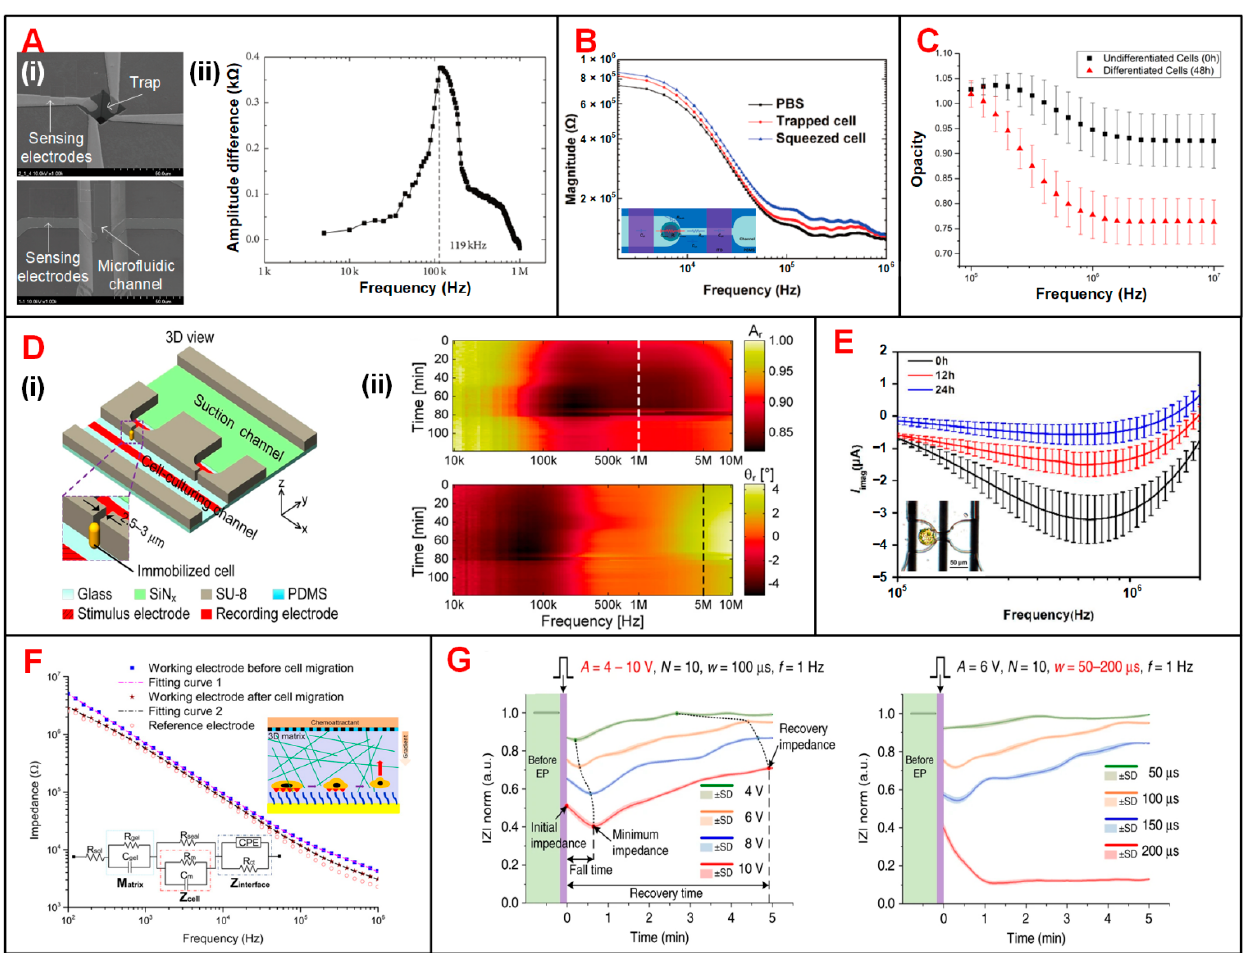
Figure 9. Cell-based assay using EIS sensing devices. ( A ) ( i ) SEM images of the two devices used to detect cancerous urothelial cells. Left one is an EIS sensing device with a negative pressure trap used to investigate the optimal frequency. Right one is an IFC device to perform high-throughput electrical impedance measurement of normal and cancerous urothelial cells. ( ii ) Measurement of the amplitude difference between normal and cancerous urothelial cells in the frequency range of 5 kHz to 1 MHz. Reproduced from [150] with the permission from Hindawi. ( B ) Schematics of a EIS sensing device to measure the amplitude and phase signal of MCF-7 cells under three typical conditions: PBS solution without cells, cell trapped and cell squeezed. Reproduced from [82] with the permission from Springer. ( C ) Using a EIS sensing device with microfluidic traps to distinguish the undifferentiated and differentiated cells by measuring the impedance over the frequency range from 100 kHz to 10 MHz. Reproduced from [95] with the permission from Elsevier. ( D ) ( i ) Schematics of an EIS-integrated single-cell culturing device for immobilization and impedance recording of Schizosaccharomyces pombe ( S. pombe ) cells. ( ii ) Recorded EIS amplitude and phase signals over the frequency range from 10 kHz to 10 MHz showing the growth and division of single S. pombe cells. Reproduced from [94] with the permission from Nature. ( E ) Imaginary part of current response for Arabidopsis mesophyll cells at different status (0 h, 12 h and 24 h after incubation, respectively). Reproduced from [148] with the permission from Elsevier. ( F ) The Bode impedance spectra measured on working electrode before and after cell migration, as well as on reference electrode without cells over the frequency range from 100 Hz to 1 MHz. Reproduced from [85] with the permission from American Chemical Society. ( G ) Recording of |Z| norm for HeLa cells in the recovery process under different conditions of electroporation. A , N , w and f stand for pulse amplitude, number, width and frequency, respectively. Reproduced from [153] with the permission from